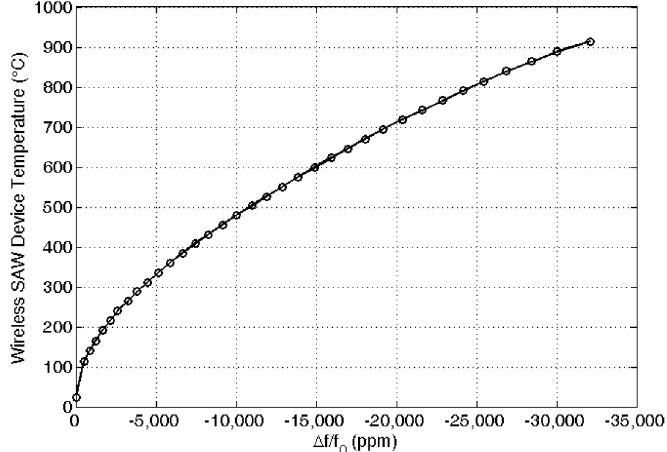
Figure 8. The measured frequency shift with increasing temperatures up to 925 °C [66] (copyright 2011 by the IEEE).